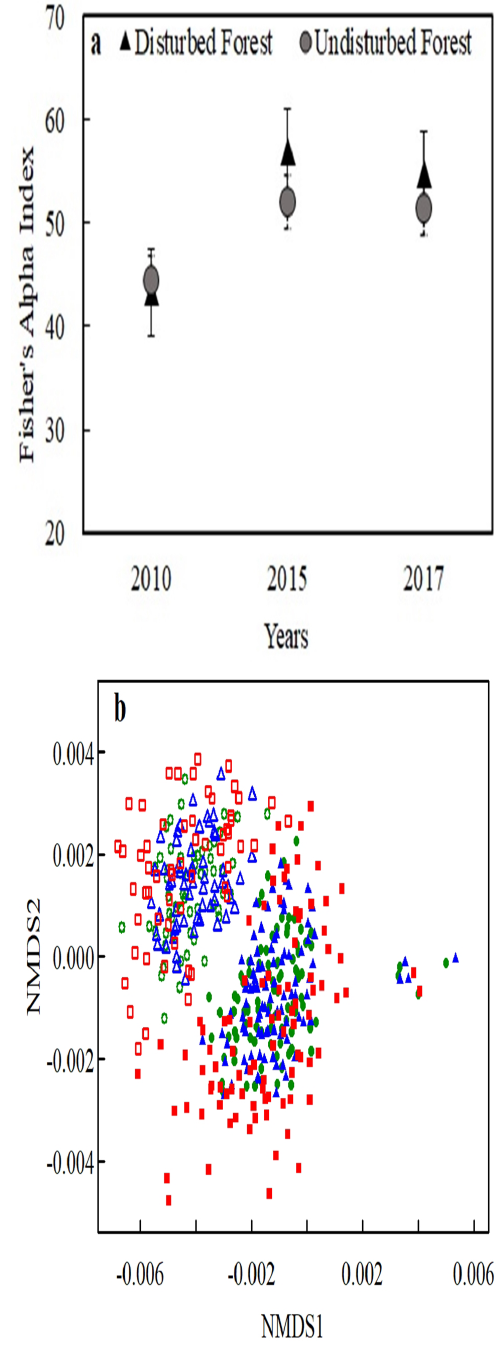
Figure 3. Species diversity obtained by Fisher’s Alpha index for DF and UF (a). Ordering of NMDS analysis for species composition, filled points correspond to disturbed forest and unfilled points correspond to undisturbed forest; circle, triangle and square symbols correspond to the years 2010, 2015 and 2017, respectively (b). Tapajós National Forest, Pará,